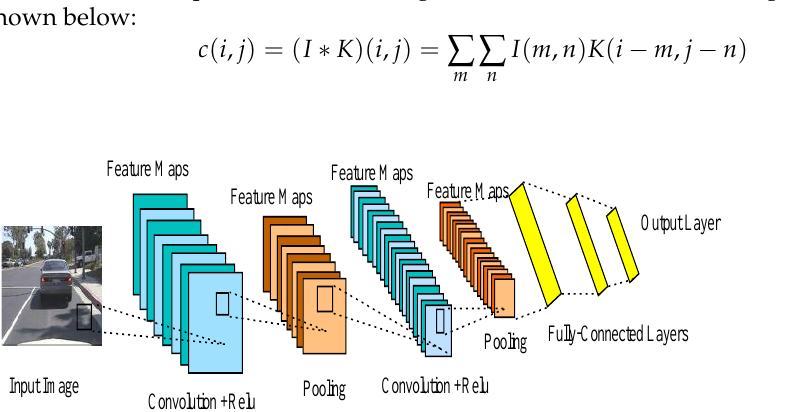
Figure 4. A simple deep convolutional neural network (DCNN) architecture. Adapted from [87].